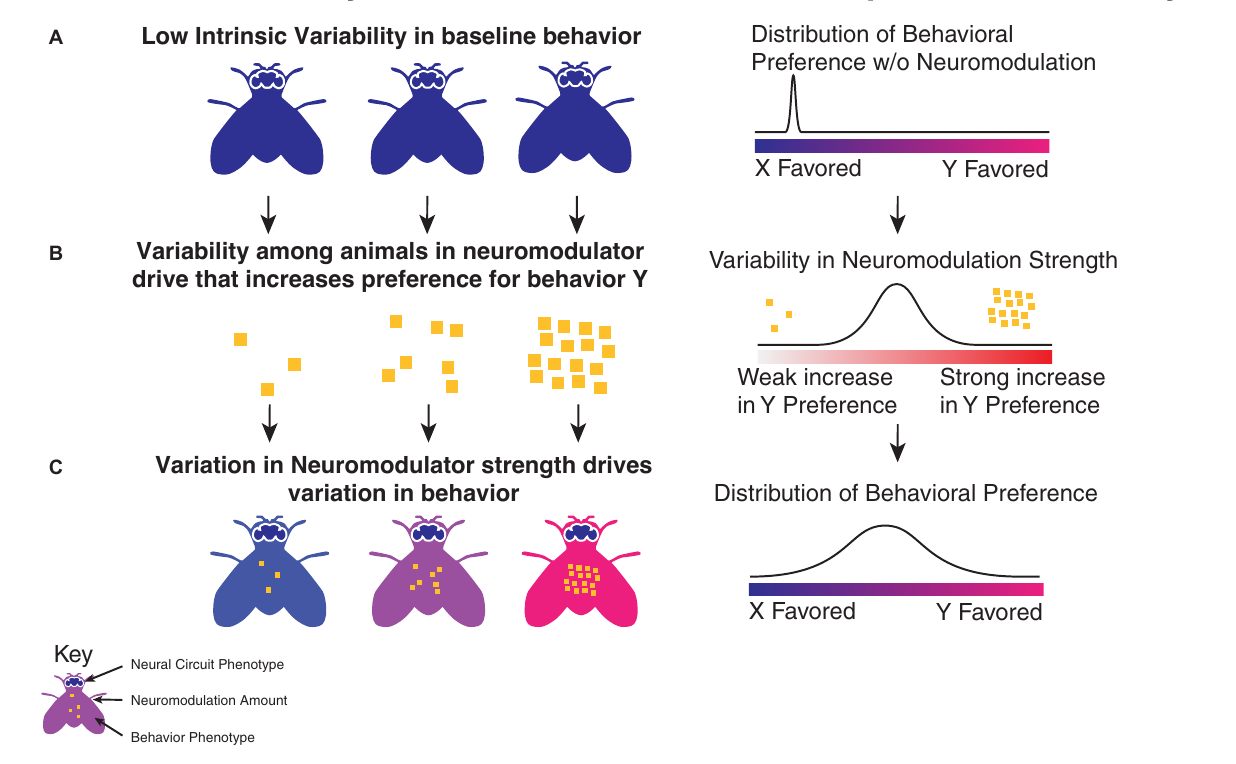
FIGURE 1 | Variation in neuromodulation as driver of behavioral output. (A) In this model, individuals show limited variability in their behavior (indicated by individual body color) in the absence of neuromodulation, reflecting low variability in underlying parameters in neural circuits (indicated by brain coloring). (B) Individuals instead show significant variability in the strength of their neuromodulatory drive, which drives changes in their behavior. (C) This leads to increased variation in the observed behavioral preference.